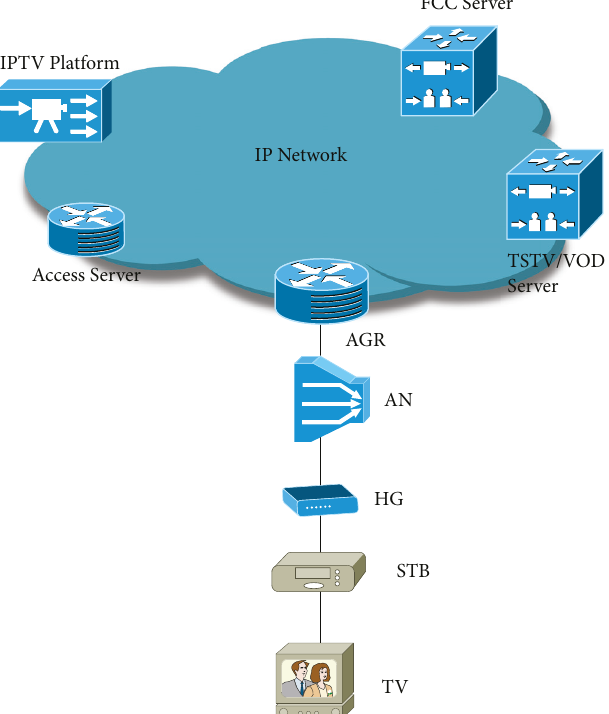
Figure 1: Architecture of IPTV